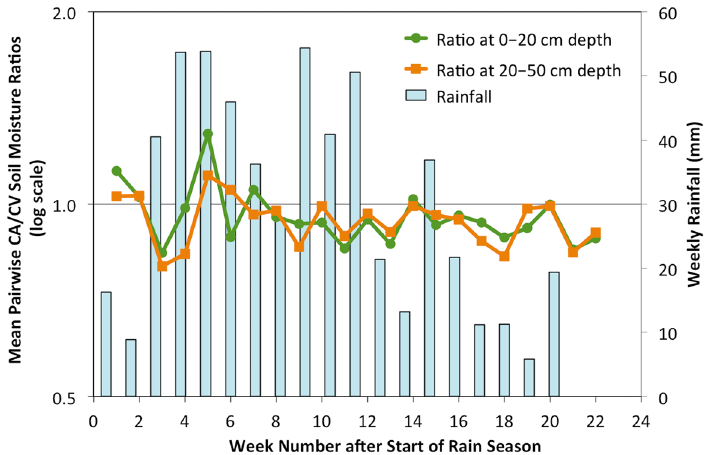
Figure 6. Mean weekly ratios of soil moisture between riplines/basins relative to moisture in paired ploughed/ridged fields (CA/CV) at two soil depths for the 2014/15 cropping season plus mean weekly rainfall in the Mumbwa, Monze, and Chipata areas.